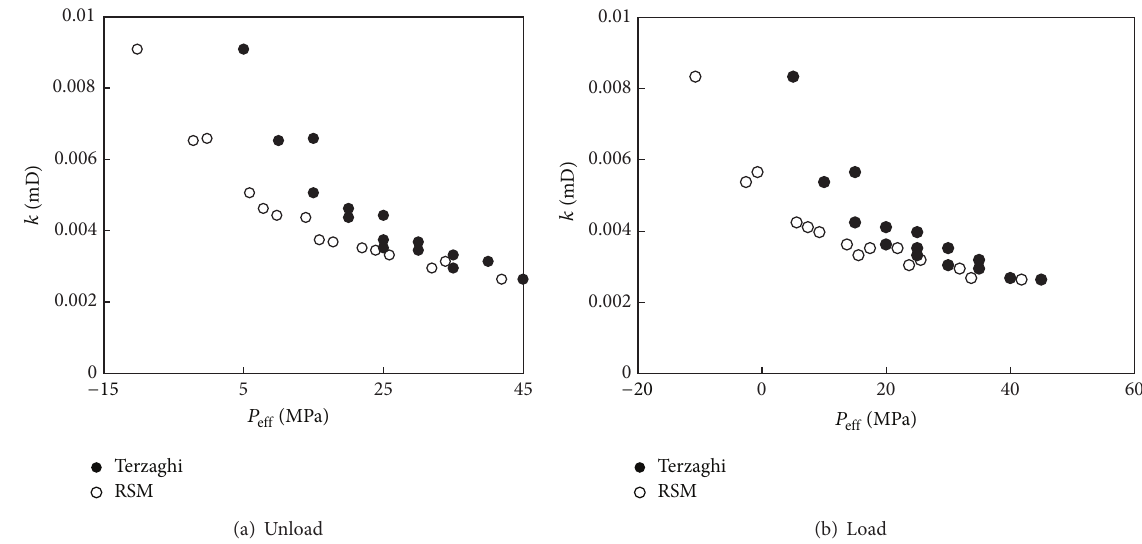
Figure 12: Permeability versus effective pressure under brine condition during pore pressure unloading (a)/loading (b) processes.